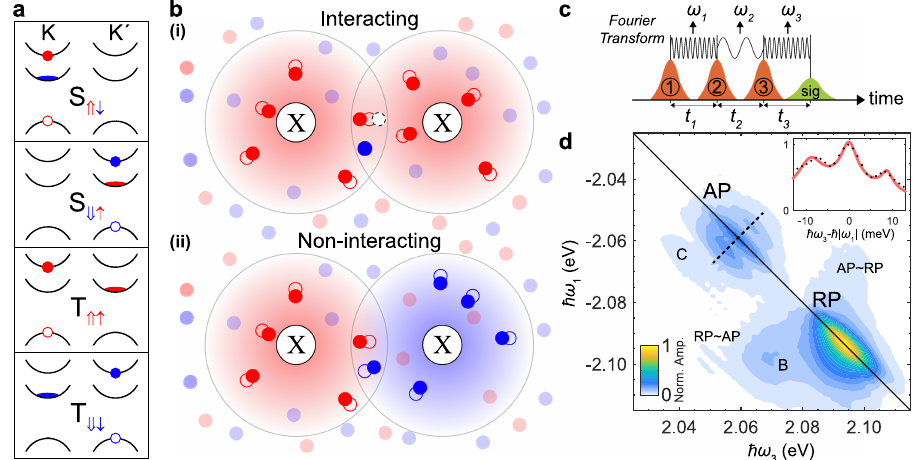
Fig. 1 | Characterizing polaronstates and their interactions in monolayer WS 2 . a The band ordering in monolayer WS 2 gives rise to four distinct attractive polaronstates,whichwelabelbytheassociatedsingletandtripletcon fi gurations. An exciton consisting of an electron (solid circle) and hole (empty circle) can be dressedbyaFermiseainthelowerconductionband(depictedas fl attenedovals). The red (blue) coloring indicates spin-up (-down) electrons. b Schematic depic- tion of attractive polarons and the interactions observed. In (i), two excitons (X) are dressed by the same Fermi sea of " electrons (solid red circles), which are displaced from their equilibrium positions (empty red circles). Between the excitons,an " electronisinteractingwiththeleftexciton,makingitunavailableto interact with the exciton on the right (empty white dashed circle). This phase- space fi lling effect leads to an effective repulsive interaction between the two polarons dressed by the same Fermi sea. By contrast, in (ii) the polarons involve distinct Fermi seas, and thus there are no phase-space fi lling effects and the polarons do not interact via the medium. c The pulse ordering in a 1Q rephasing